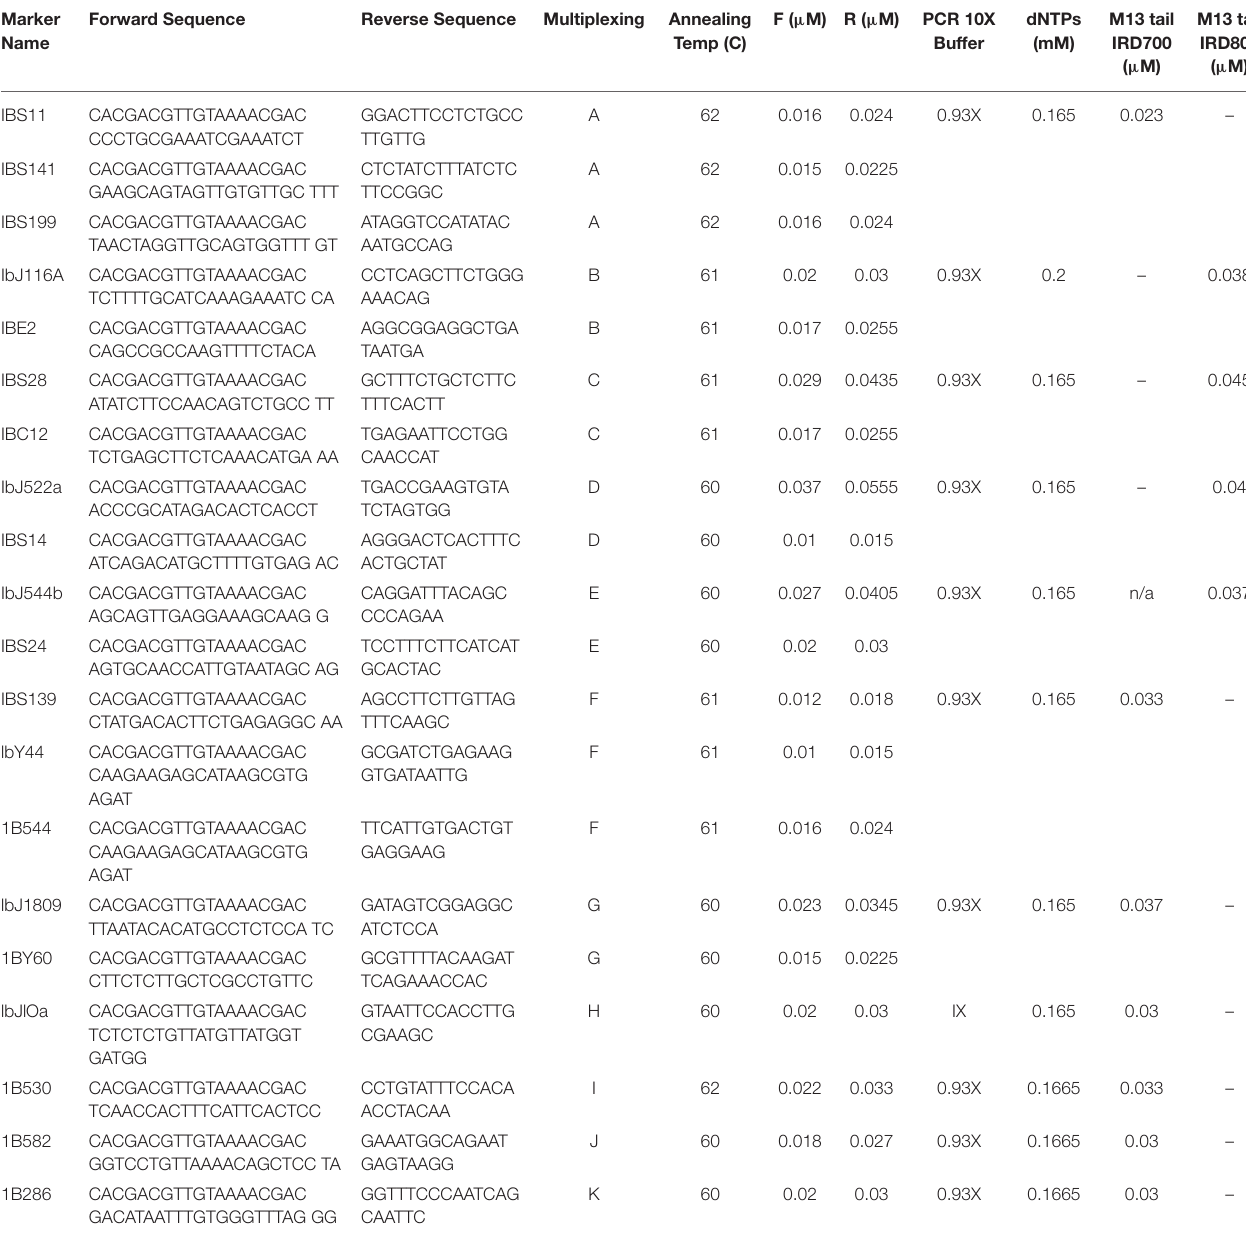
TABLE 1 | List of sequences for the 20 Simple Sequence Repeat (SSR) markers employed in this